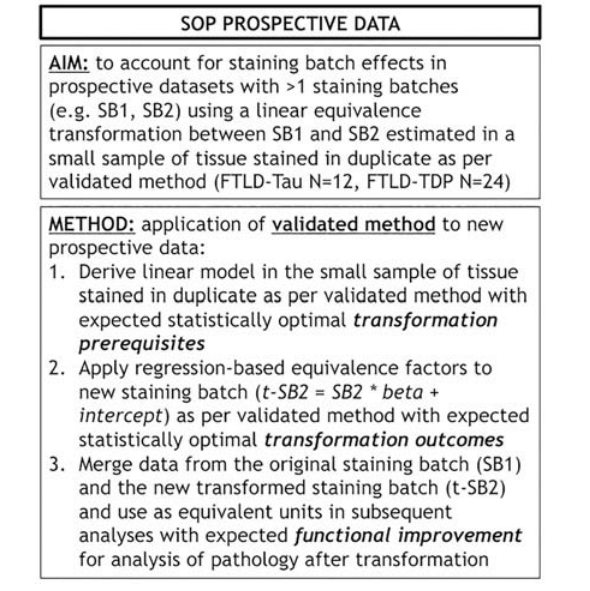
FIGURE 7 | Standard operating procedure for prospective use of our validated transformation method. Panel outlines a standard operating procedure (SOP) for prospective addition of new data to existing datasets where we use our validated transformation method to account for staining batch effects. FTLD-Tau, frontotemporal lobar degeneration with inclusions of the tau protein; FTLD-TDP, frontotemporal lobar degeneration with inclusions of the transactive response DNA-binding protein 43; LMN, number of tissue samples; SB1, staining batch 1 (original); SB2, staining batch 2 (new); SOP, standard operating procedure; t-SB2, transformed staining batch 2